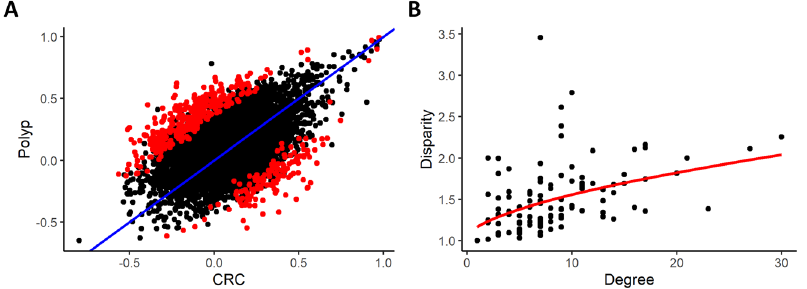
Figure 3: In panel (A), scatterplot of metabolites pair correlations in CRC subjects ( x axis) and polyp ( y axis) and identification of significant ( p -value cutoff 0.05 using a 1000-fold permutation test) pairs in red. In panel (B), scatterplot of the disparity measure ( y axis) in function of the nodes’ degree ( x axis) and the fitting curve y ∝ x 3 ∕ 5 .